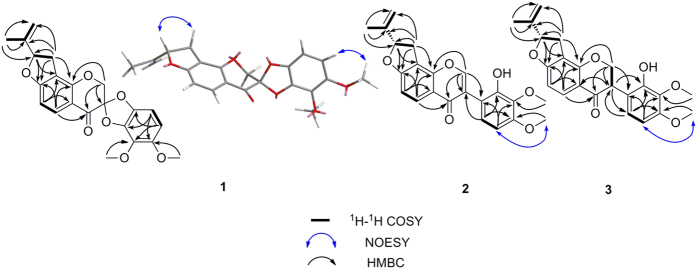
Key 1H-1H COSY, HMBC and NOESY correlations of 1–3.